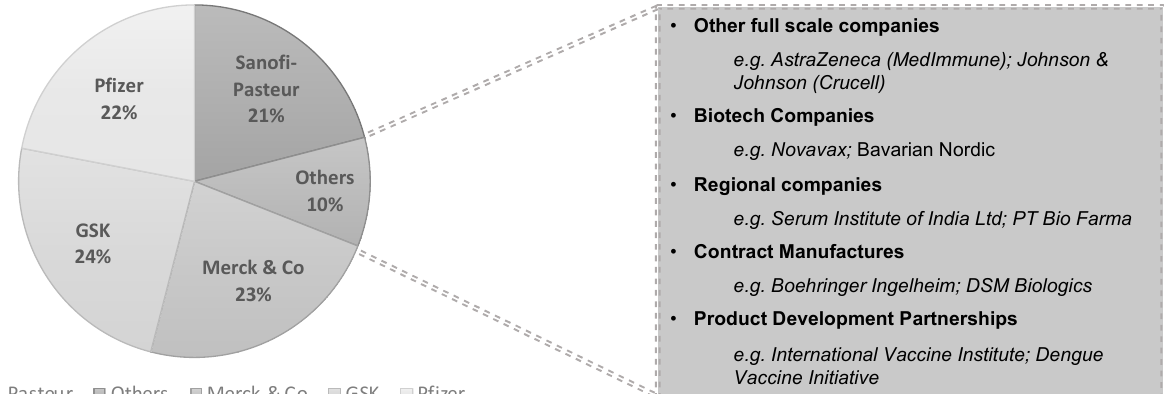
Figure 1. Global vaccine leaders market shares [8,10] . Adapted by permission of Springer Nature Customer Service Centre GmbH: Nature [ Nat. Rev. Drug Discov. ] [8], (Shen, A.K. and Cooke, M.T. Infectious Disease Vaccines, 2019), [copyright]